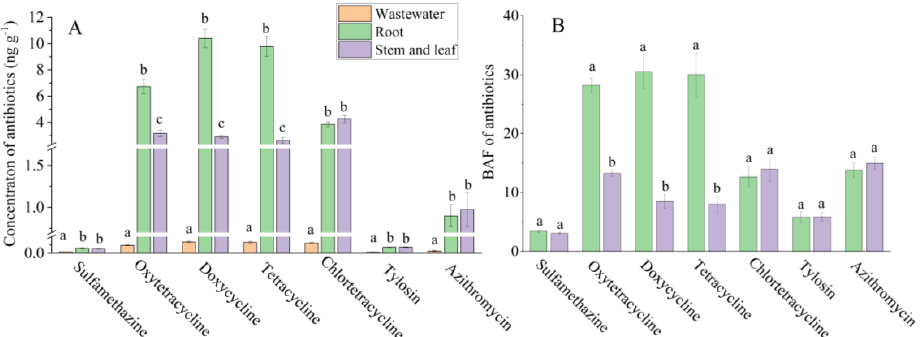
Figure 1. The concentrations of antibiotics in livestock wastewater and water dropwort ( A ). The antibiotic enrichment capacities of roots and stems and leaves ( B ). Different letters indicate significant differences between livestock wastewater, roots, and stems and leaves ( p < 0.05). BAF = C plant /C wastewater , where C plant is the concentration of roots or stems and leaves and C wastewater is the concentration of livestock wastewater.